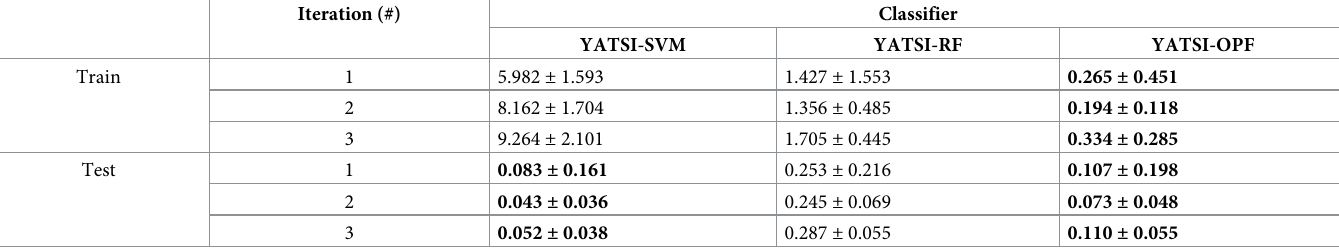
Table 5. Average computational times and standard deviations (in milliseconds) per iteration for the training and testing processes, using the semi-supervised clas- sifiers for the E.coli dataset. The best results (shorter times) are highlighted in bold.